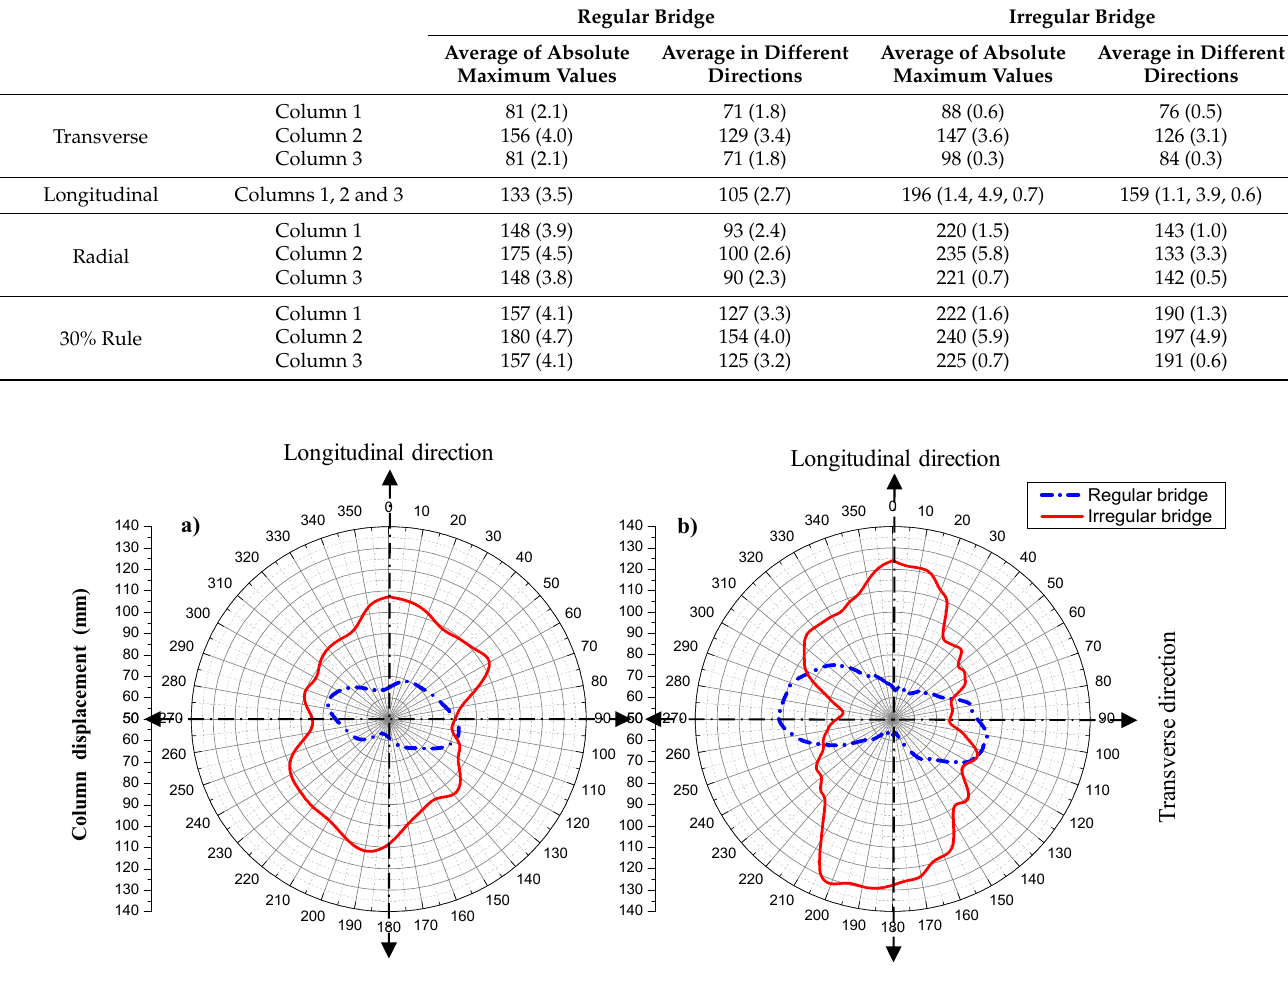
Figure 12. Mean displacement of the central column of the bridges along different directions for: ( a ) records applied along the principal axes of bridges; ( b ) records applied at their critical angle, θ cr.